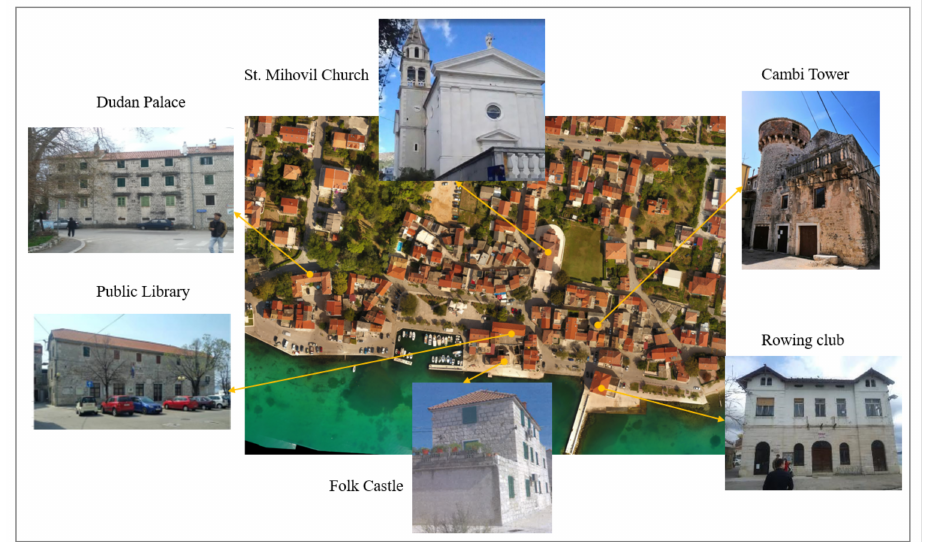
Figure 2. Historic center with typical buildings, Kaštel Kambelovac.